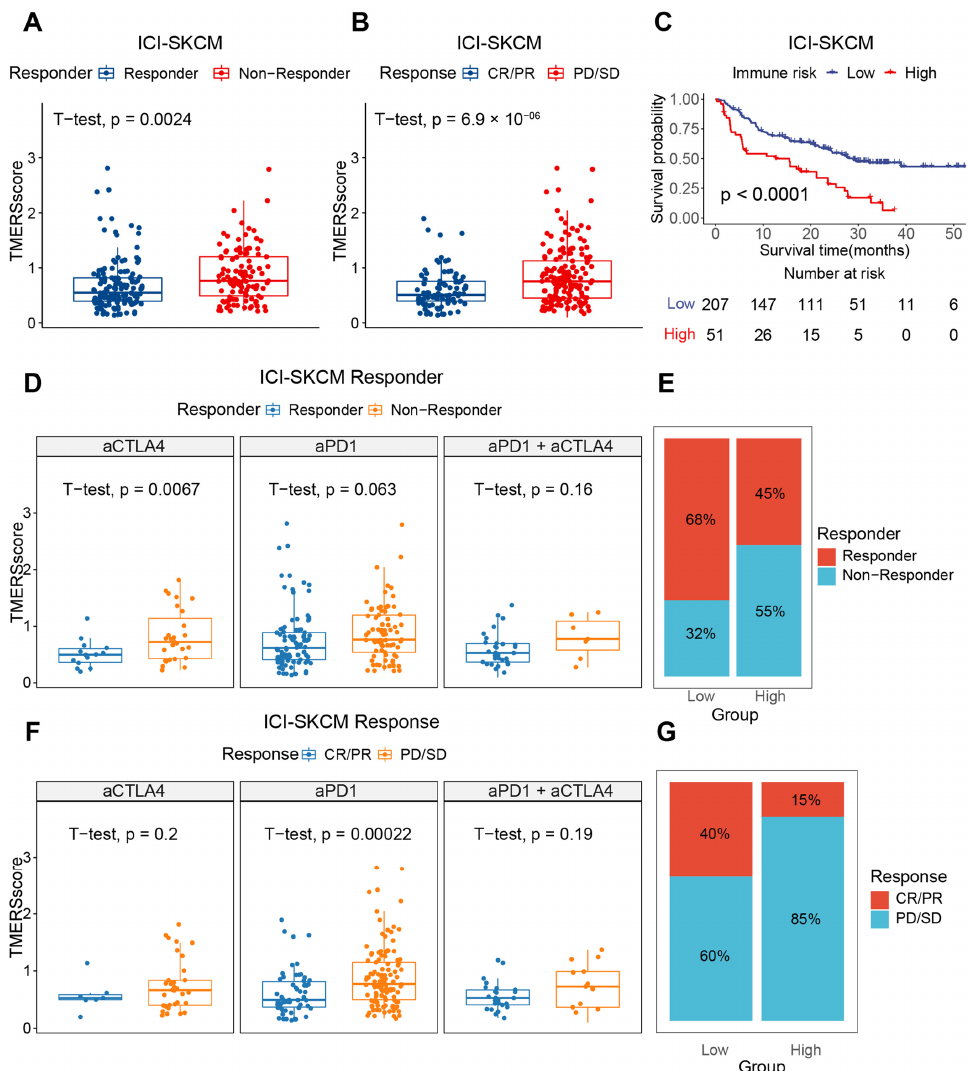
Figure 8. Evaluation of ICI therapeutic efficacy by TMERSscore in SKCM cohort. ( A , B ) Boxplots showing the difference in TMERSscore between responders and non-responders, and between CR/PR subgroups and PD/SD subgroups in the SKCM cohort receiving ICI treatment, respectively. ( C ) Kaplan-Meier survival curve of the TMERSscore in ICI-treated SKCM cohort. ( D , F ) Boxplots showing the difference between responders and non-responders of TMERSscore in the SKCM cohort for different ICI therapies, i.e., anti-CTLA4, anti-PD-1, anti-PD-1 combined anti-CTLA4, and between the CR/PR subgroup and the PD/SD subgroup, respectively. ( E , G ) Bar charts showing the percentage of responders vs. non-responders and CR/PR vs. PD/SD in different TMERSscore subgroups in the SKCM cohort, respectively. Responders include CR, PR, and PD response subgroups, and non-responders include SD response subgroups.